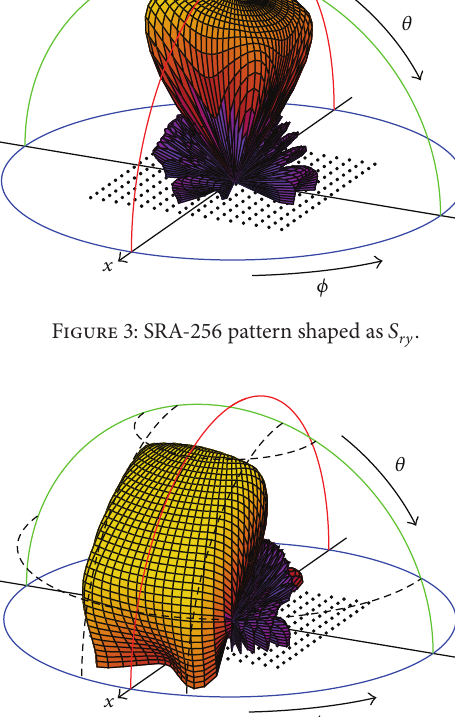
𝑦 -axes. Figure 5 depicts the 𝑆